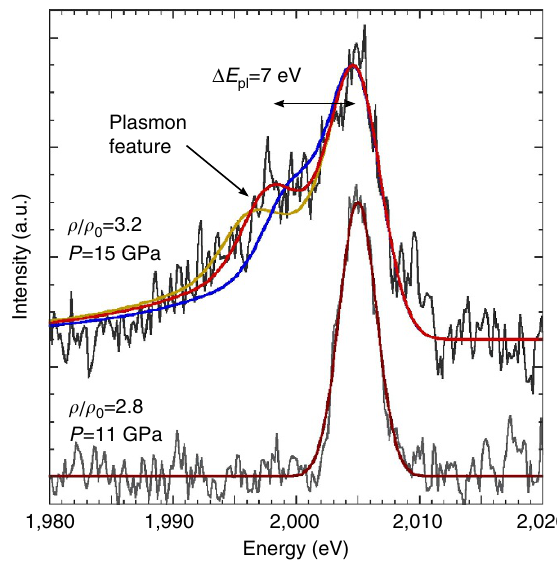
Figure 4 | Measured forward scattering spectra with theoretical fits. Pressure and compression are inferred from VISAR measurements. X-ray forward scattering spectrum from 3.2 (cid:3) shock-compressed D 2 showing elastic scatter at 2005eV and downshifted plasmon with theoretical fits corresponding to T e ¼ 0.15eV and n e ¼ 1.3 (blue), 2.5 (red) and 4.0 (yellow) (cid:3) 10 22 cm (cid:2) 3 . Below, a spectrum from 2.8 (cid:3) compressed D 2 showing no evidence of free electrons as a visible inelastic scattering